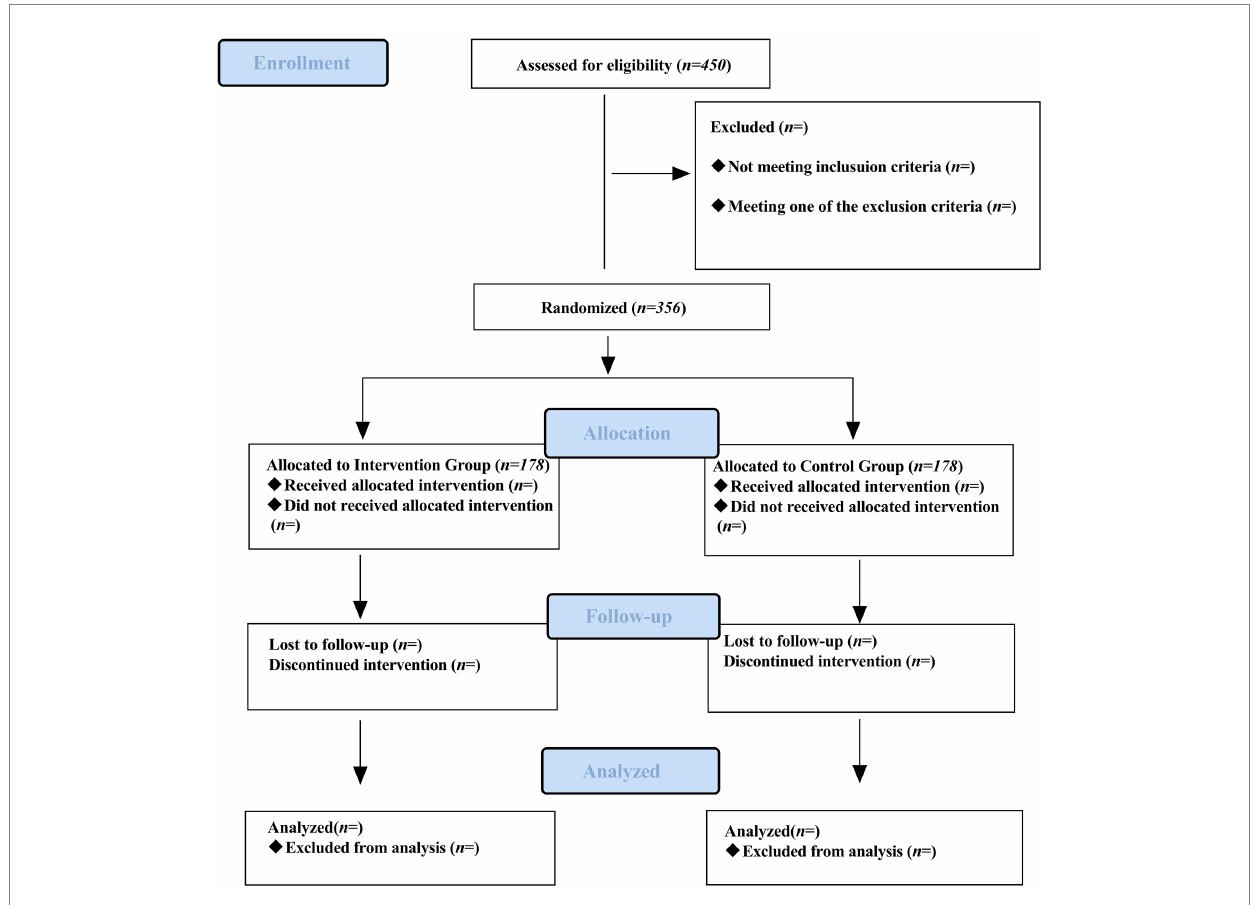
FIGURE 1 Flow chart of participant enrollment, intervention, assessments, and